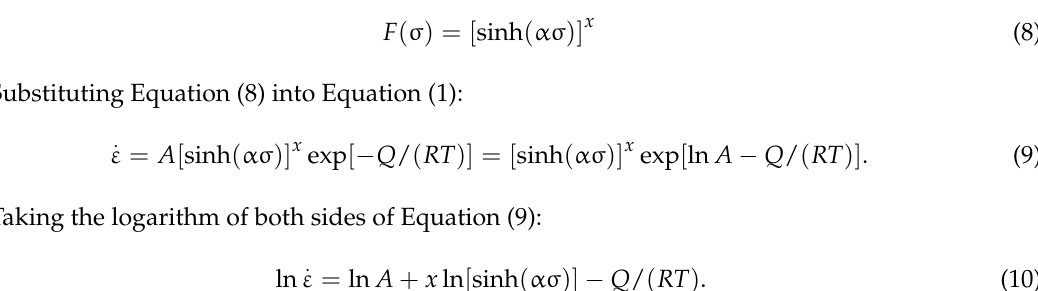
. . . ε - σ ; ( b ) ln ε -ln σ ; ( c ) ln ε -ln[sinh( ασ